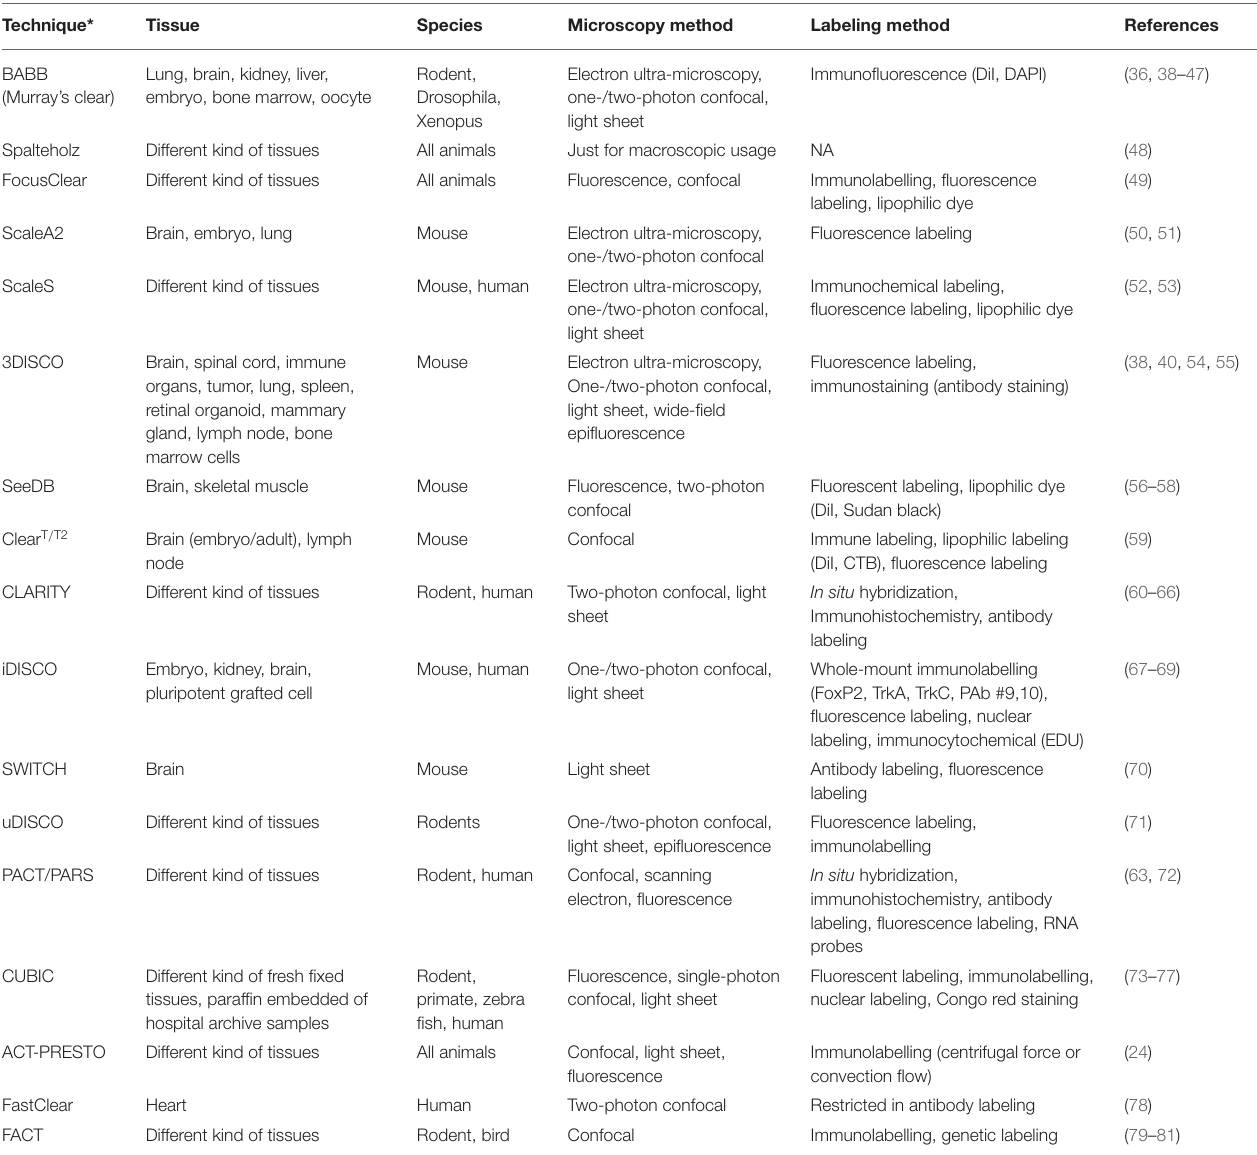
TABLE 3 | Different tissues clearing technique for three-dimensional